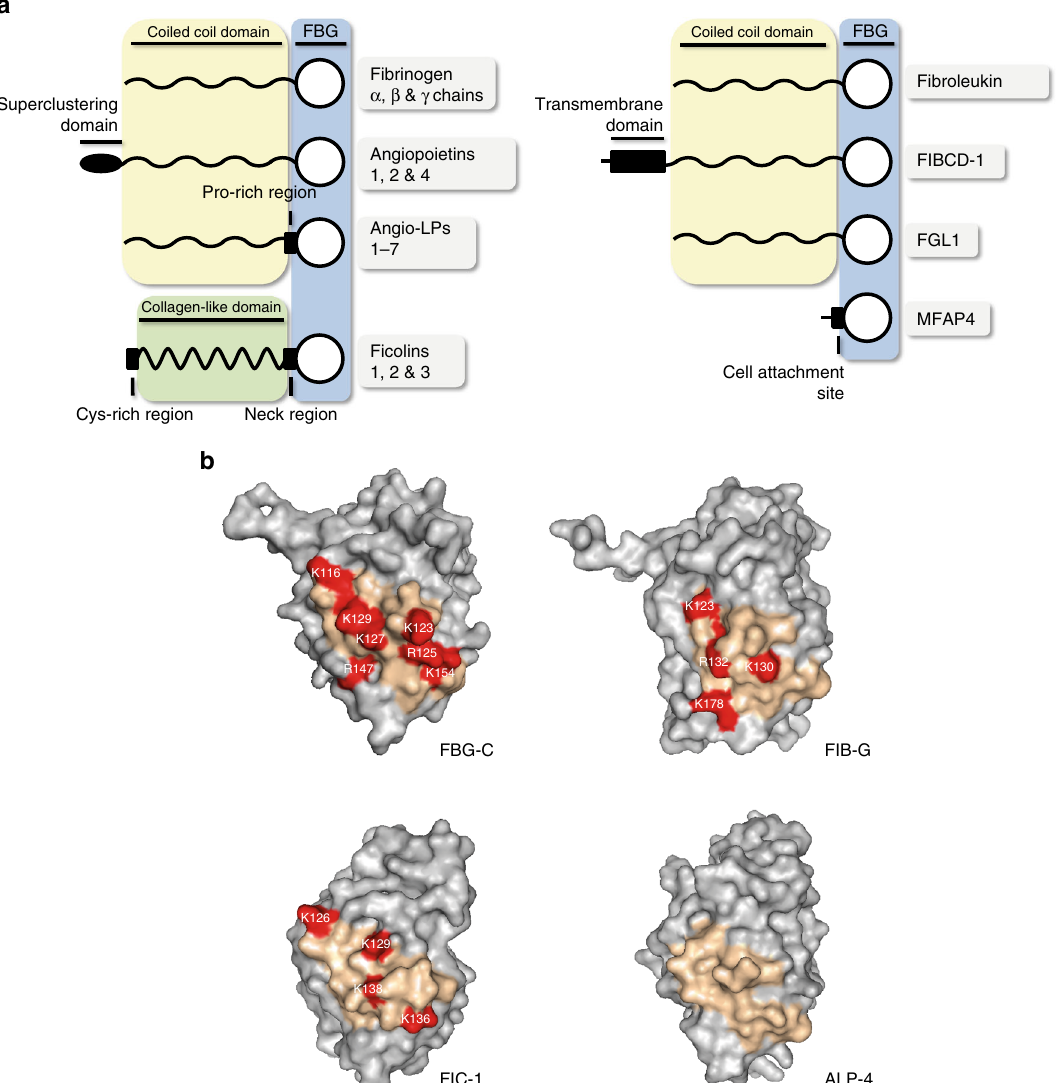
Fig. 6 A conserved cationic ridge in fi brinogen-related proteins (FRePs). a Simpli fi ed domain organization of human FRePs: each protein contains distinct N-terminal sequences but all possess a C-terminal FBG domain, including the four tenascin family members (shown in Fig. 1a), α , β , and γ chains of fi brinogen, the three angiopoietins, seven of the angiopoietin-like proteins (Angio-LPs), the three fi colins, fi broleukin, FIBCD-1, FGL1, and MFAP4. b The cationic loop 5 ridge present in FBG-C, -R, and -W, but absent in FBG-X, is conserved in a subset of FRePs, which possess a comparable structural epitope made up of residues from loops 5, 6, and 7. Homology models of the FBG domains of the three FRePs selected for further analysis are shown together with that of tenascin-C (FBG-C); these include two predicted TLR4 agonists; the fi brinogen γ chain (FIB-G) and fi colin-1 (FIC-1), and one FBG domain predicted to be incapable of activating TLR4; angiopoietin-like protein 4 (ALP-4). The region created by residues from loops 5, 6, and 7 on the surface of each FBG domain is shown in pale orange, within which positively charged residues are colored